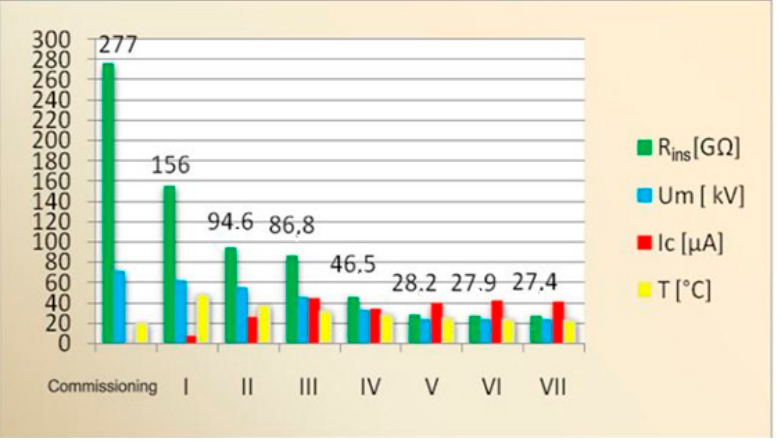
Figure 6. Graphical representation of the sizes during each test interval.